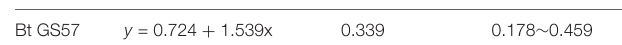
TABLE 2 | Bioassay of Bt GS57 isolates against the neonates of Spodoptera exigua. Bt